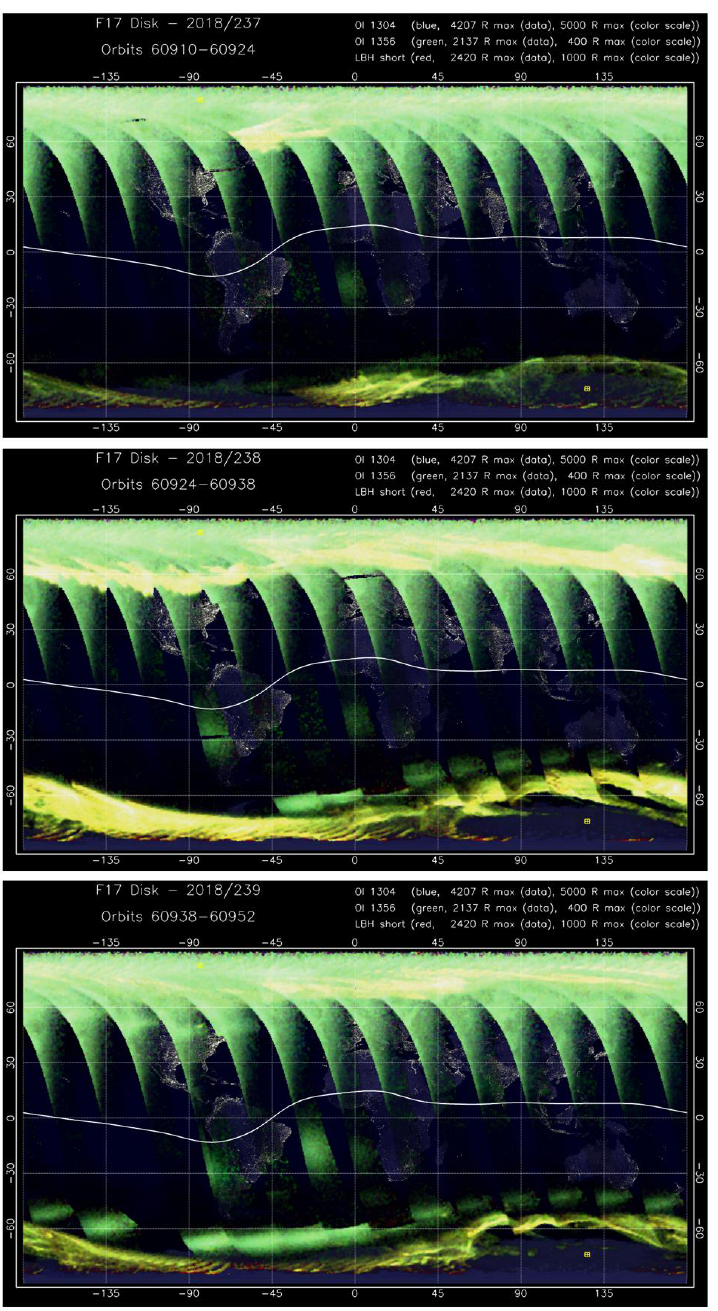
Figure 6. L1B Daily Summary Images from the Special Sensor Ultraviolet Scanning Imager (SSUSI) sensor onboard DMSP F17 satellite with a map projection of nightside disk data with nighttime solar zenith angles for 25–27 August 2018 (Day of Year 2018/237–2018/239)